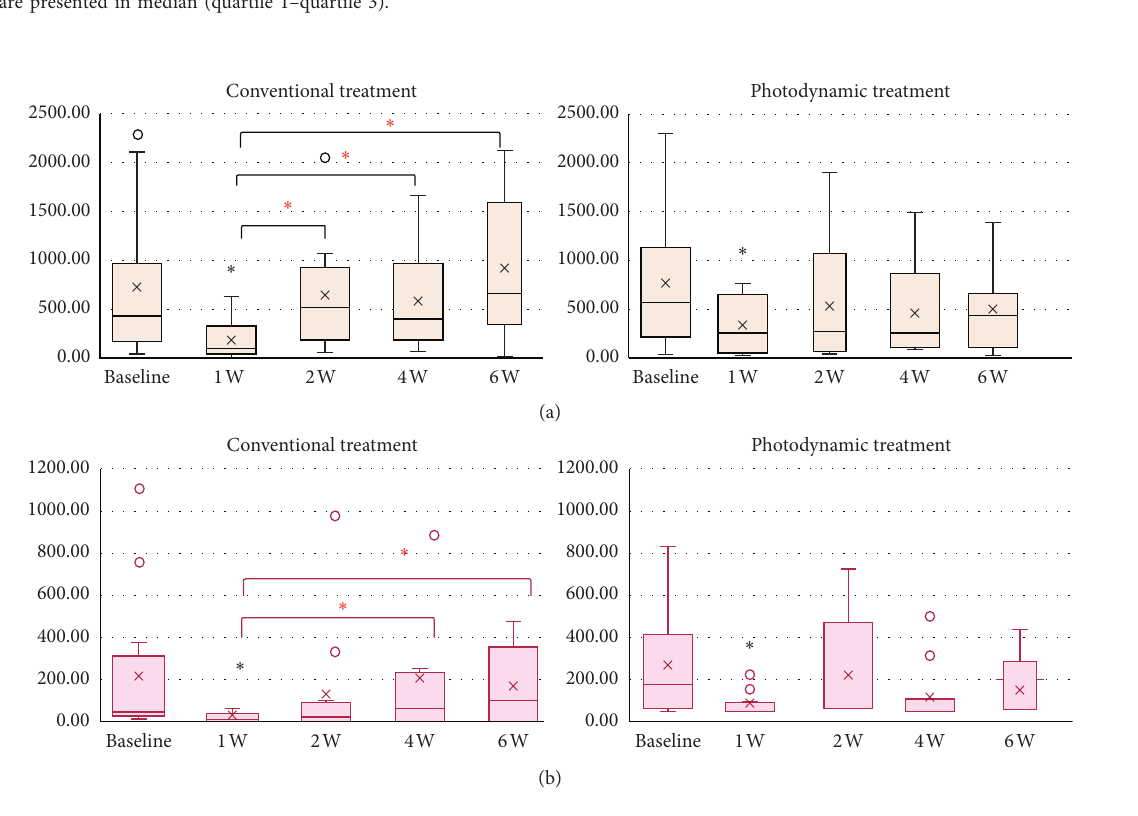
Figure 1: The median, mean, 25th to 75th percentiles, maximum, minimum, and maximum outlier of (a) F. nucleatum and (b) P. intermedia from baseline through 6 weeks of follow-up.